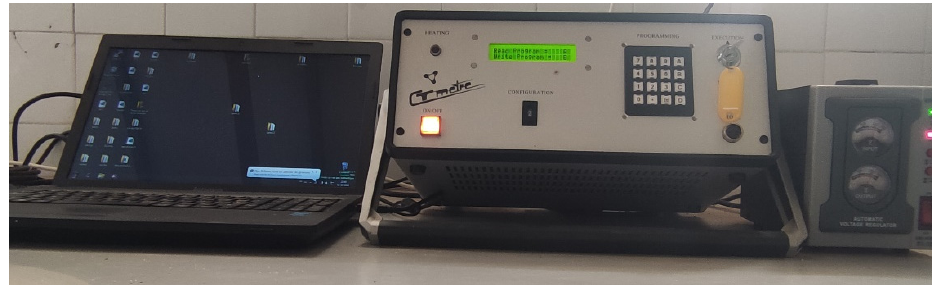
Figure 4. CT meter device.